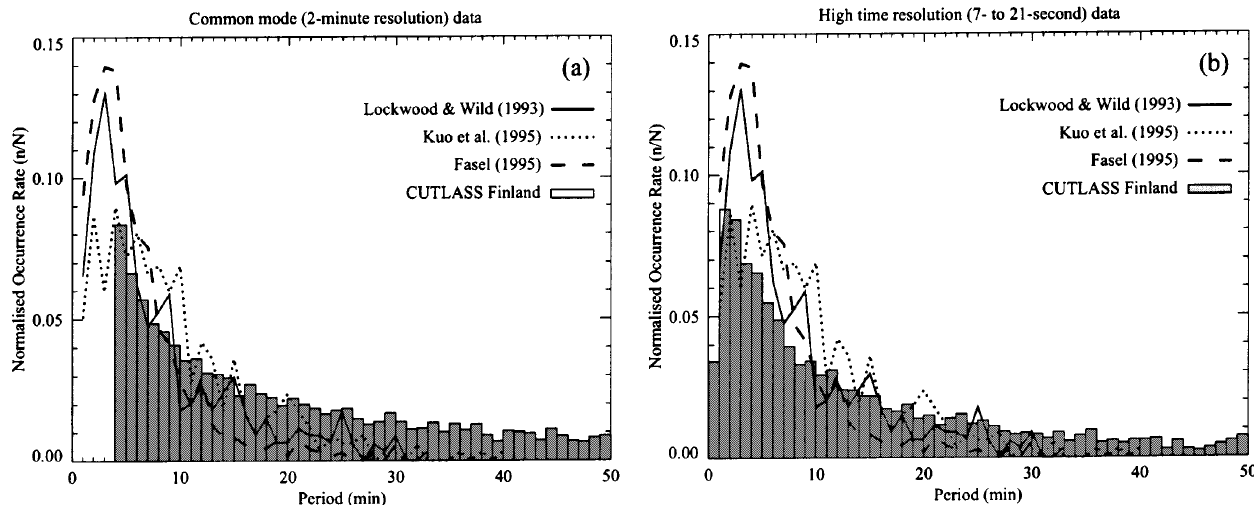
measured in the vicinity of dayside reconnection by Lockwood and Wild (1993) and Kuo et al . (1995), respectively. The dashed line is the distribution of the time between ground-based optical measurements of poleward moving auroral forms (Fasel, 1995)